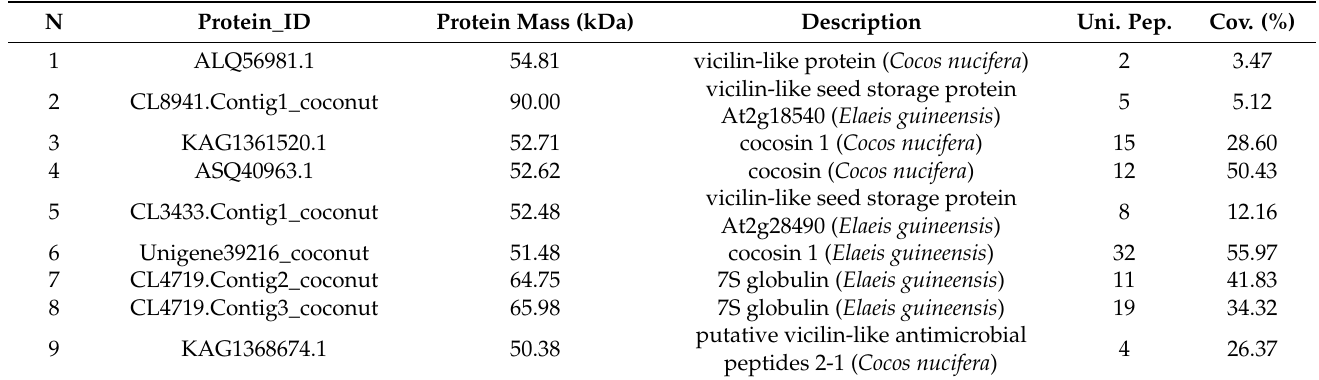
Table 1. C. nucifera proteome (globulin, FDR < 1%).